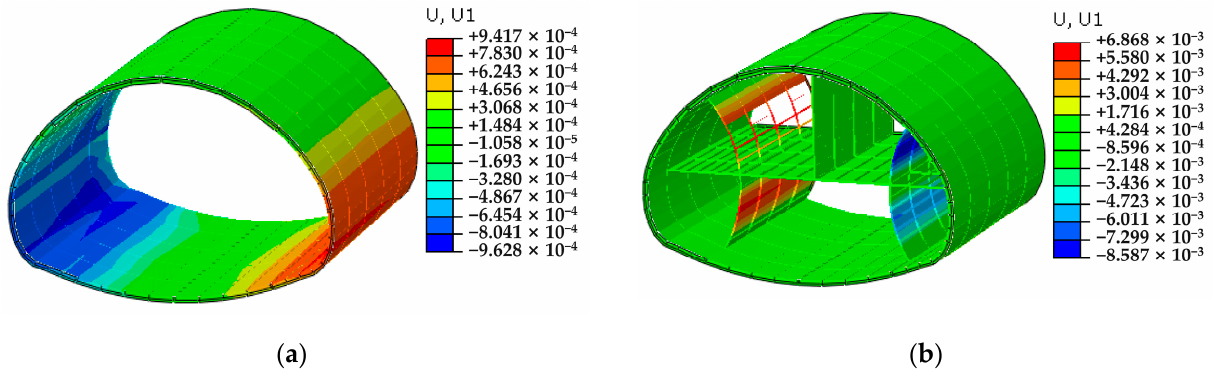
Figure 22. The horizontal displacement of the lining after the temporary support was removed (unit: m): ( a ) Condition 1 and ( b ) Condition 2.